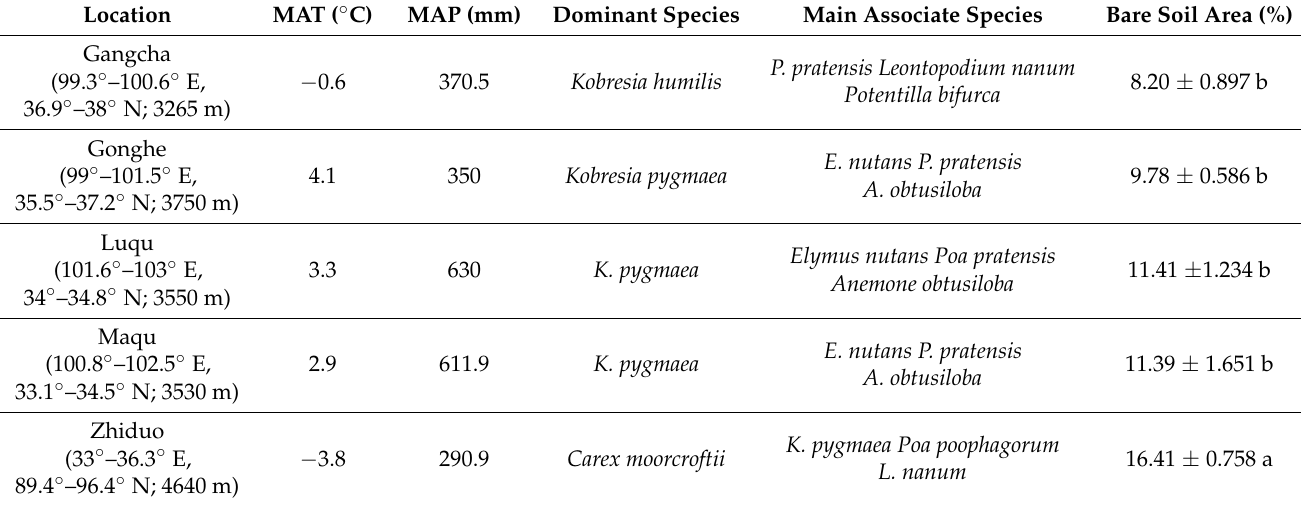
Table 1. Locations, MAT, MAP, dominant species, main associate species and bare soil bare induced by plateau pika at each of five sites. MAT, mean annual temperature; MAP, mean annual precipitation. Percentage bare soil area of the total plot area (35 m × 35 m) in the disturbed plots was presented as Mean ± Std. Error, and significance was evaluated using one-way ANOVA with the Tukey post hoc test. Different letters denote significant differences at p < 0.05.